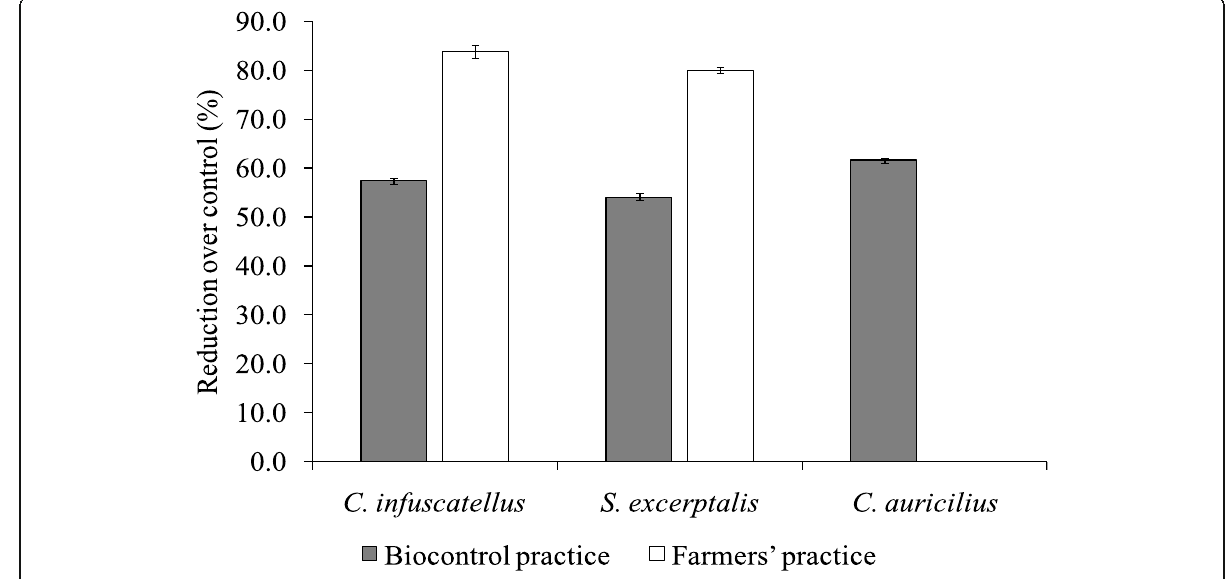
Fig. 2 Percent reduction in the incidence of sugarcane borers over untreated control (pooled mean of 5